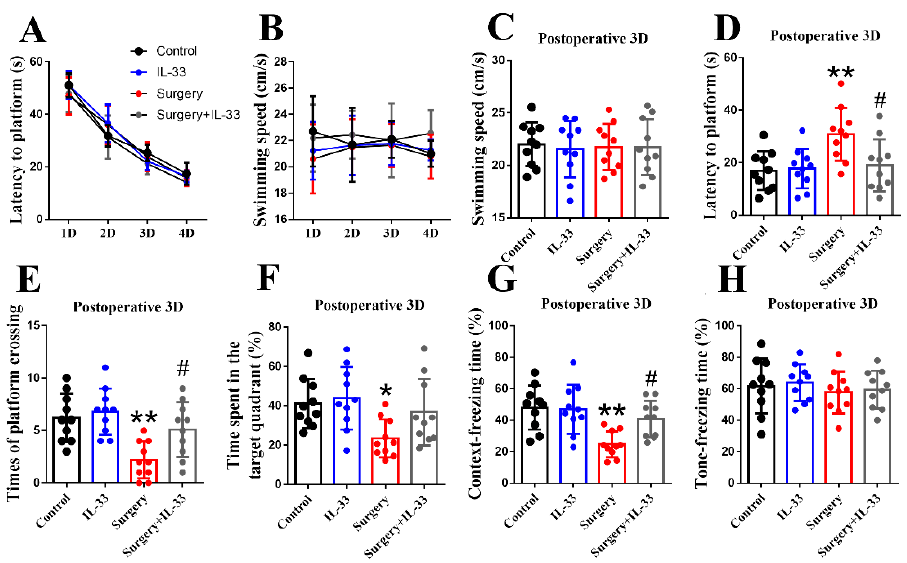
Figure 2. IL-33 alleviates surgery/anesthesia-induced cognitive impairment in mice. Latency to platform ( A ) and swimming speed ( B ) were recorded in the place navigation of MWM on days 1–4 before surgery/anesthesia. Swimming speed ( C ), latency to platform ( D ), times of platform crossing ( E ), the time spent in the target quadrant ( F ), freezing time in the context test ( G ) and tone test ( H ) were recorded on days 3 after surgery. Data are expressed as the mean ± SD (repeated measure two-way ANOVA followed by Bonferroni’s post hoc test, n = 10 per group). * p < 0.05 and ** p < 0.01 versus the control group; # p < 0.05 versus the surgery